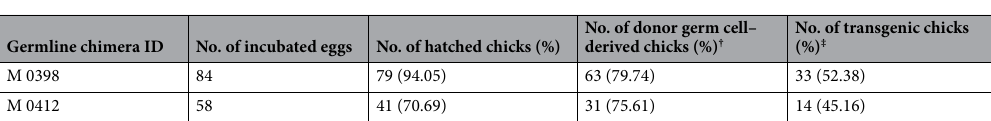
Table 1. Efficiency of germ-line transmission and transgenic chick production with MGSTII-tg donor PGCs. † The phenotype of offspring derived from donor PGCs of WL chickens ( I/I ). ‡ The percentage of donor germ cell–derived chicks that expressed